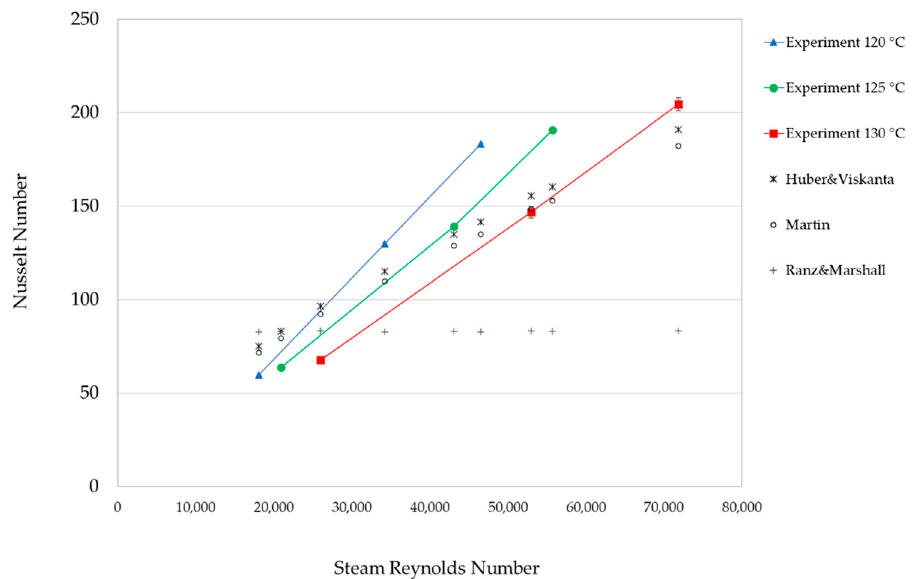
Figure 3. Effect of Reynolds number on Nusselt number at H / d = 5, water injection with 2 nozzles, and steam temperature of 120 °C, 125 °C, and 130 °C. We also show the impingement predictive correlations by Huber and Viskanta and by Martin and the conventional steam injection correlation by Ranz and Marshall. Table 3. The correlations of the Nusselt number as a function of Reynolds number, Nu = c 1 Re m. The Correlations c 1 m R 2 Experiment at 120 °C